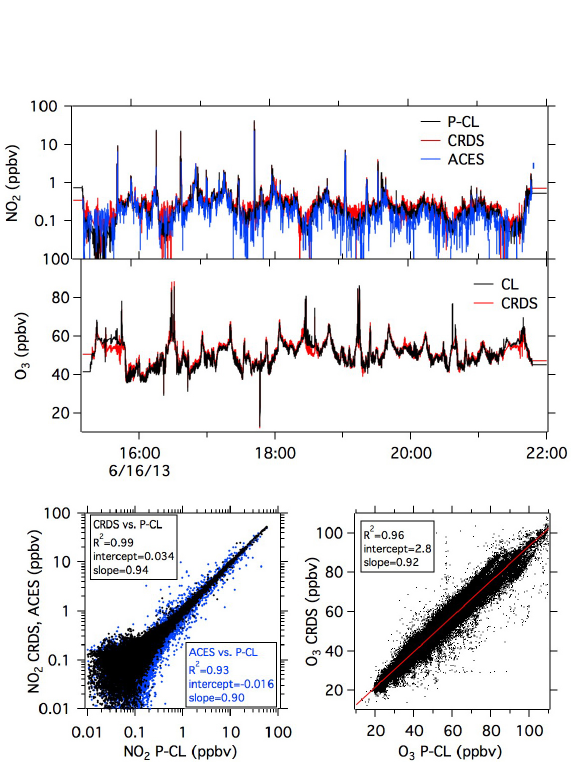
Figure 3. NO 2 inter-comparison between P-CL, CRDS and ACES instruments and ozone inter-comparison between P-CL and CRDS.